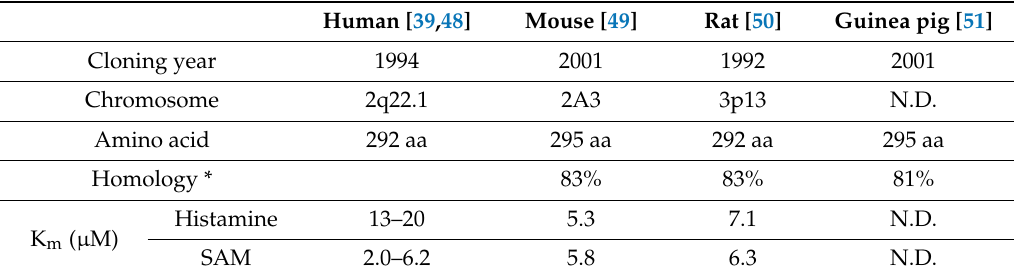
Figure 2. Enzymatic activity of histamine N -methyltransferase. Histamine N -methyltransferase catalyses the transfer of a methyl group from S-adenosyl- L -methionine to histamine, yielding N τ -methylhistamine and S-adenosyl- L -homocysteine. Table 1. Basic data of human, mouse, rat, and guinea pig histamine N -methyltransferase (HNMT).